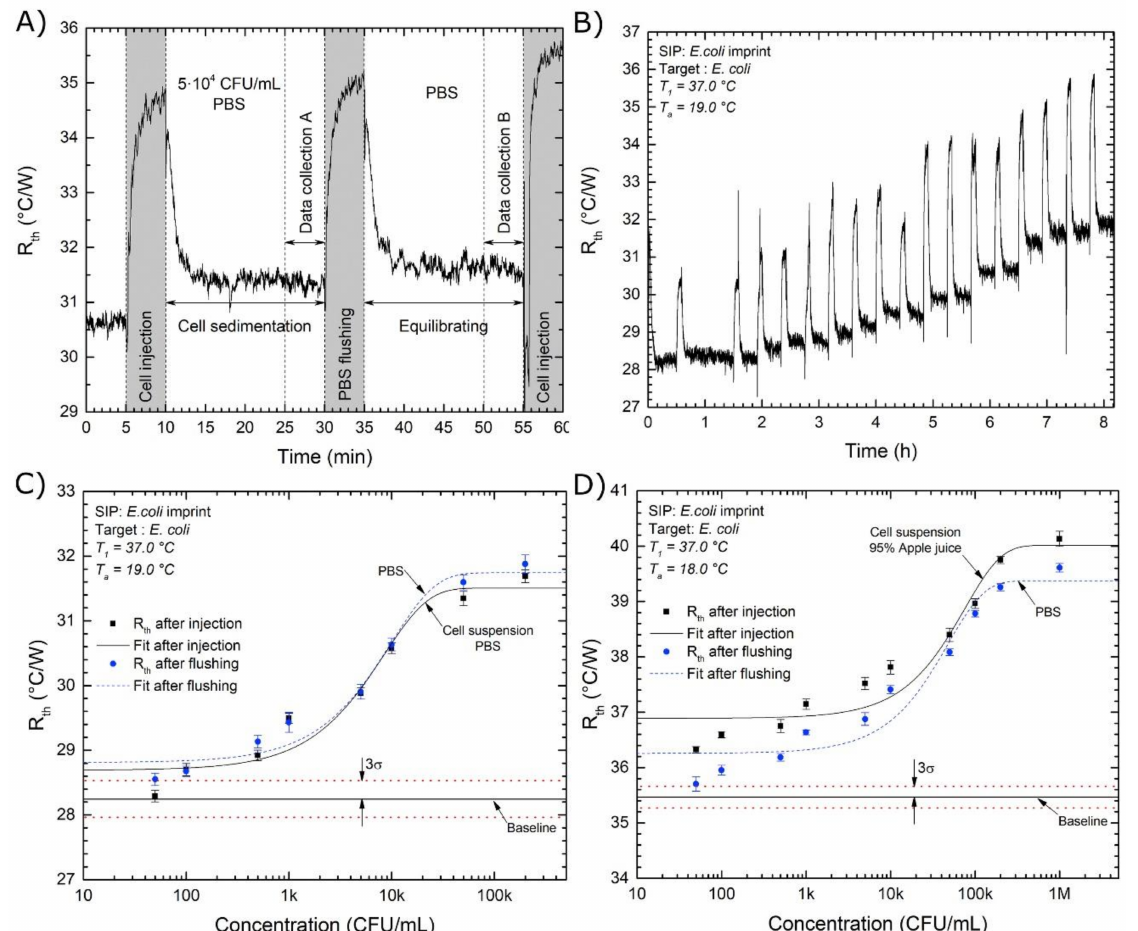
Figure 8. ( A ) Typical four-step exposure protocol ( B ) Dose-response experiment for E. coli sensing. The sensor was exposed to increasing bacteria concentrations in PBS buffer (50, 100, 500, 1 × 10 3 , 5 × 10 3 , 1 × 10 4 , 5 × 10 4 , and 2 × 10 5 CFU/mL). Sensor was flushed with PBS buffer after each injection. ( C , D ) Dose-response curves for E. coli sensing in PBS and 95% apple juice. The LOD (3 σ of baseline measurement) is marked by the red dotted line; Reproduced with permission from [77], ©